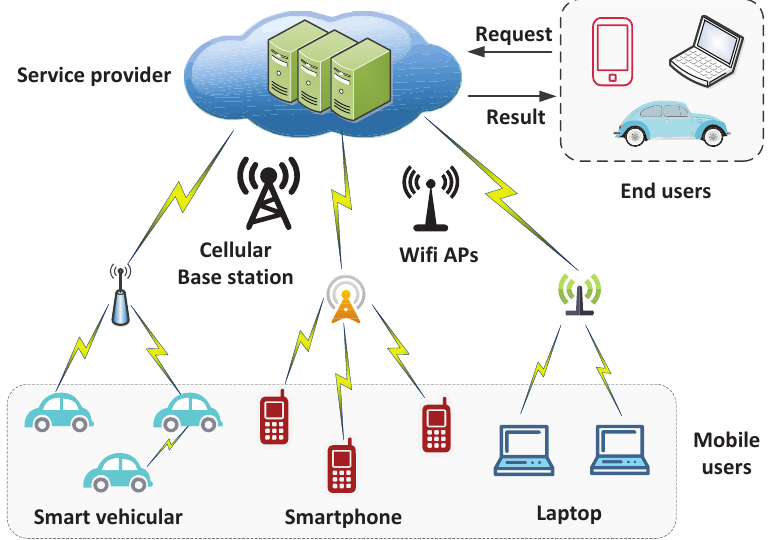
Figure 1. Mobile crowdsourcing network